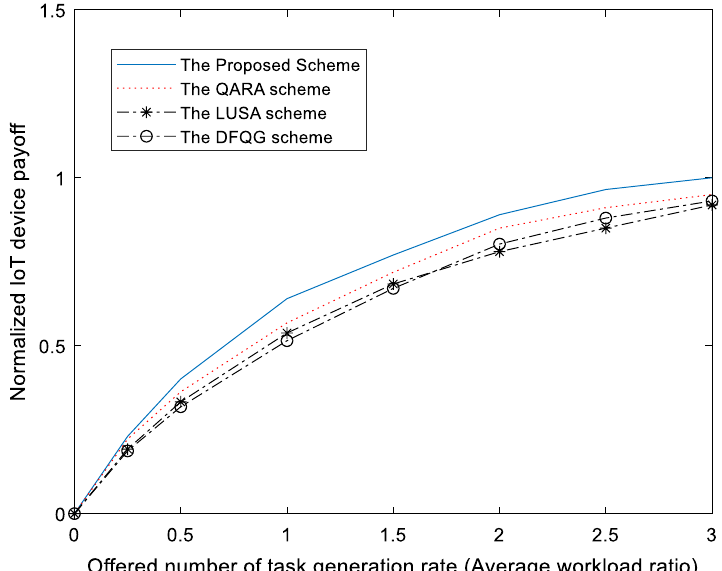
Fig. 4 Normalized IoT device payoff. The normalized IoT device payoff represents the communication resource efficiency of the LTE/WiFi